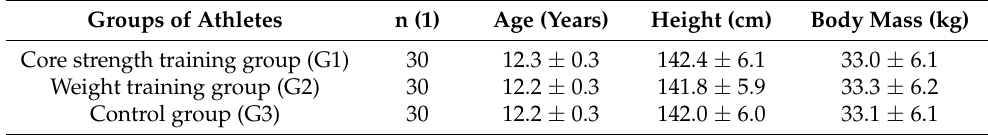
Table 1. Characteristics of participants (mean ±